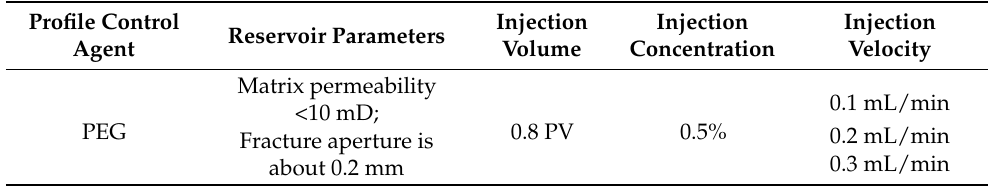
Table 8. Influence factors of PEG in low-permeability fractured